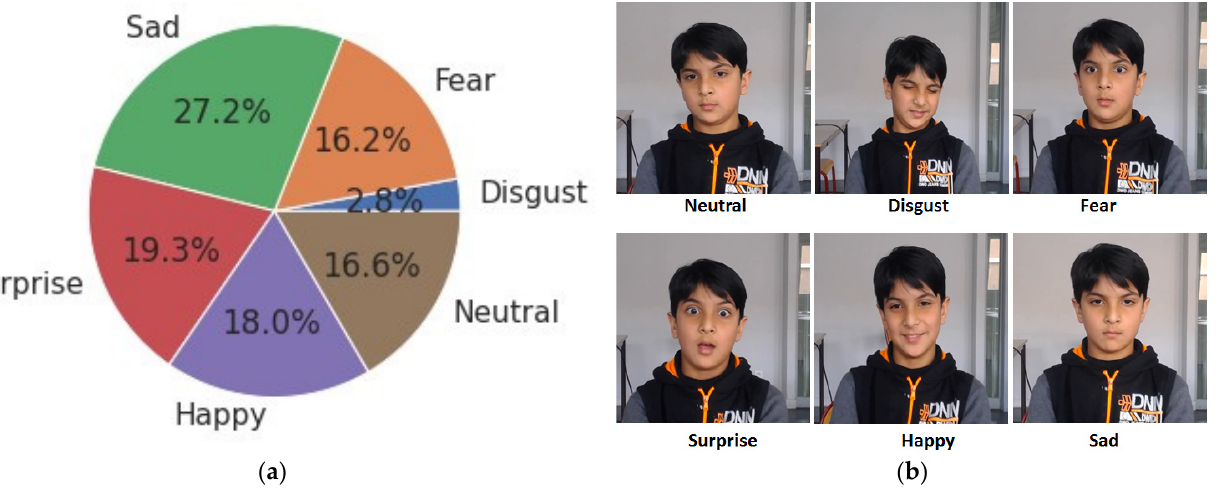
Figure 3. ( a ) LIRIS emotion distribution. ( b ) Publicly allowed sample images of LIRIS emotions.